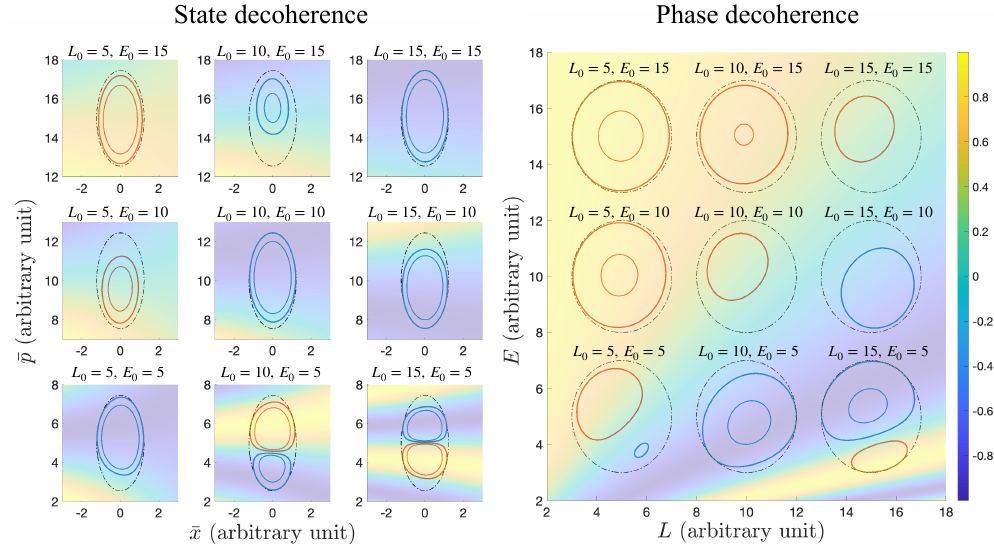
Figure 9 . Demonstration of time-independent state decoherence (left plot) and phase decoherence (right plot) plotted in a similar fashion as figure 4 and figure 5, both representing phase wash-out effects. The former is in the Wigner phase space on layer 1, while the latter is in the relativistic phase space on layer 2. The coloured contour plot in the background is the oscillating phase structure plotted as cos( η ) (left plot) and cos( ψ ) (right plot), on the corresponding layer. The jk jk outer red (blue) circles are the level for two standard deviations of positive (negative) values of the time-independent P ( X ; X ) (left plot) and P ( X ; X ) (right plot) for weighting functions ¯1 ,jk 1 3 2 ,jk 2 3 eq. (3.24) and Gaussian distributed H , respectively. The inner circle (if there is one), is the L /H E contour for one standard deviation. Also, the black dashed line is the contour for two standard deviations of the weighting